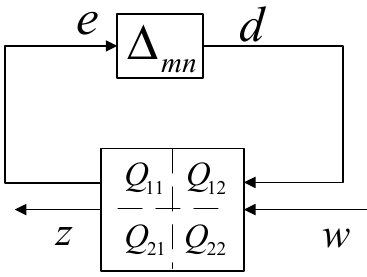
Figure 5. Representation of droop parameters as the linear fractional transformation (LFT) configuration.